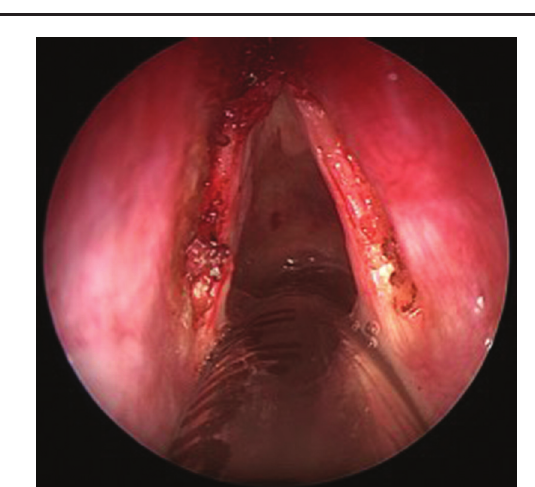
Laryngeal amyloidosis; right pedunculated mass arises from the right ventricle (black arrow) and broad base mass arises from the left true cord (green arrow).